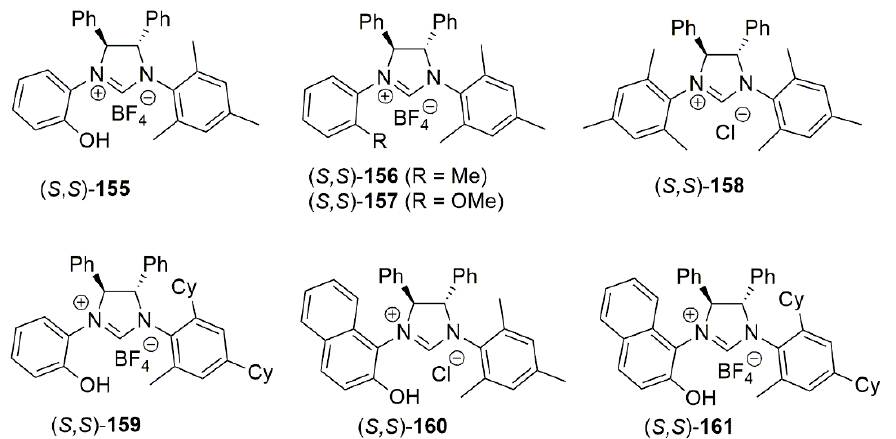
Figure 18. Mono ‐ and bidentate chiral NHC ligands developed by Sawamura [81].